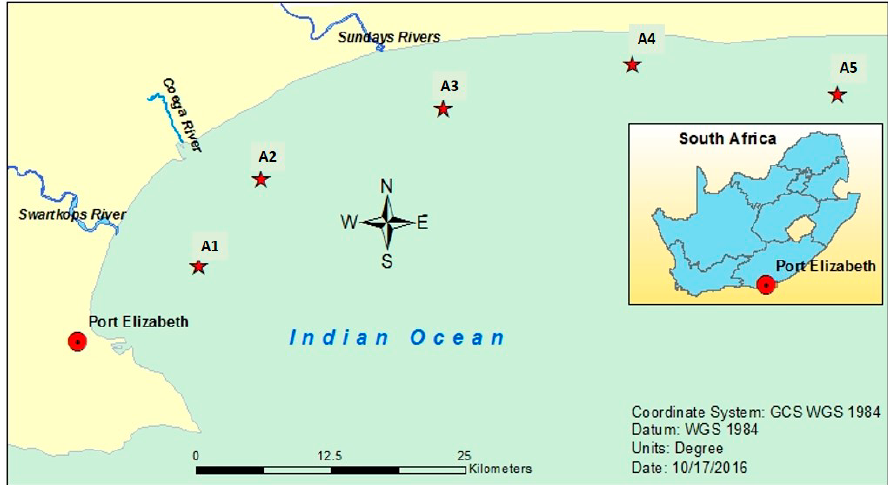
Figure 1. Map of Algoa Bay.